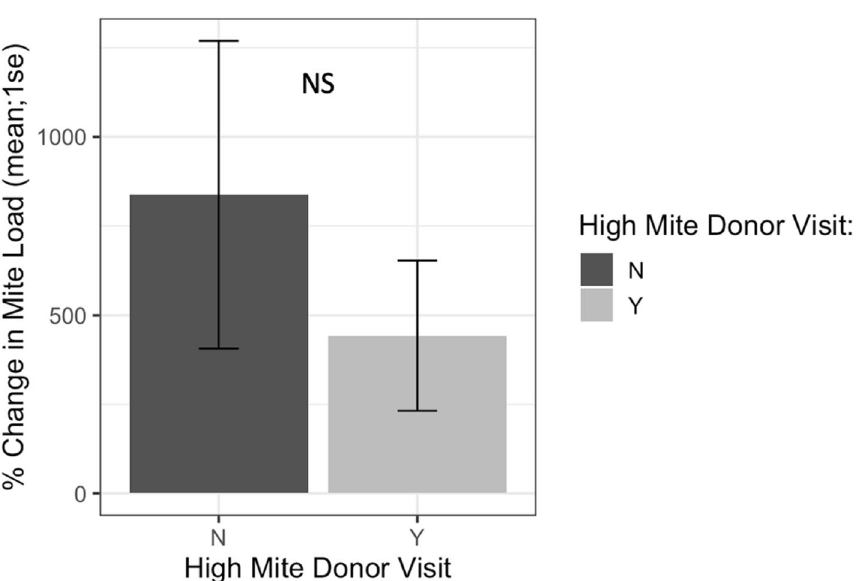
Figure 11. Percent change in Varroa loads in colonies that received high mite donor bees compared to colonies that did not receive high mite donor bees. There was no difference in percent change between colonies visited by high mite bees and unvisited colonies at the start or end of the study ( glm p =